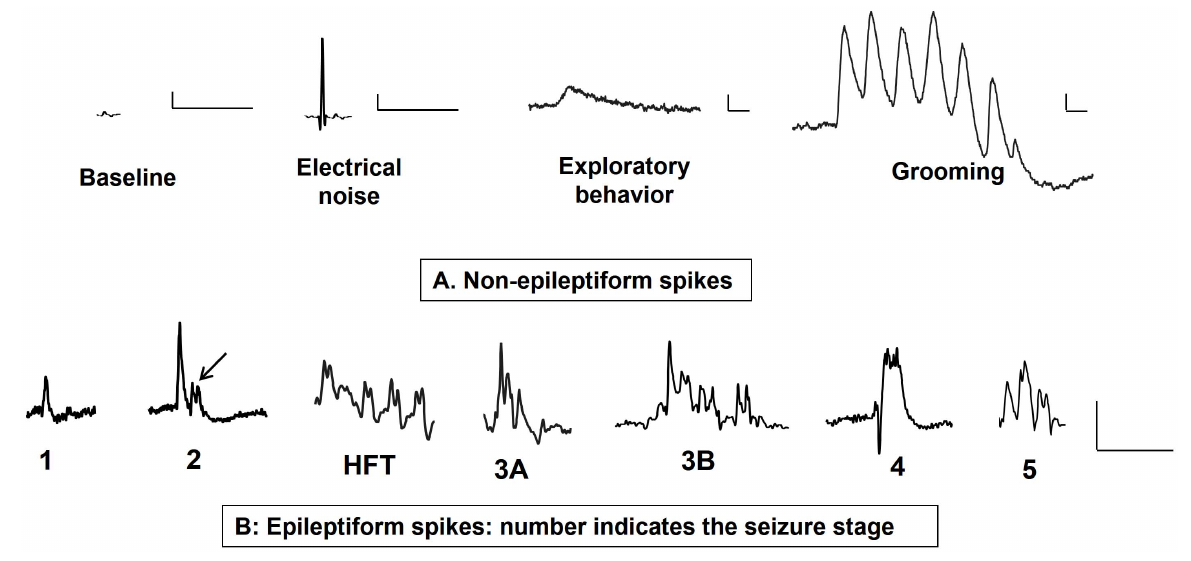
Figure 1. Individual spike characteristics on EEG. The baseline non-epileptiform spike and artifact spikes are shown in the top panel (A). The bottom panel (B) represents epileptiform spikes at different stages of seizures. Baseline spike, stage-1 and stage-2 epileptiform spikes are simple while, high frequency trigger (HFT), stage-3, -4 and -5 were complex. Stage-1 epileptiform spikes were similar to baseline spikes but had higher amplitude. Stage-2 epileptiform spikes had higher amplitude than stage-1. As stage-2 progressed towards CMS the spikes became complex with mini HFT-like spikes (indicated by the arrow). Several small spikes at the peak of the stage-4 spike gave a characteristic appearance of a paint brush. Stage- 5 epileptiform spikes had a low amplitude when compared to the stage-4 spikes but had a combination of stage-2 to-4 spikes. Scale for all: y-axis 300 m V and x-axis 300 ms.